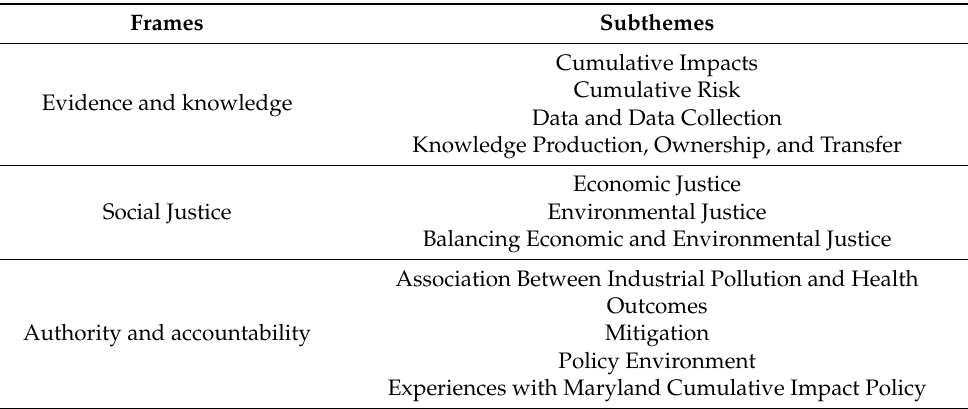
Table 4. Overview of the identified frames and